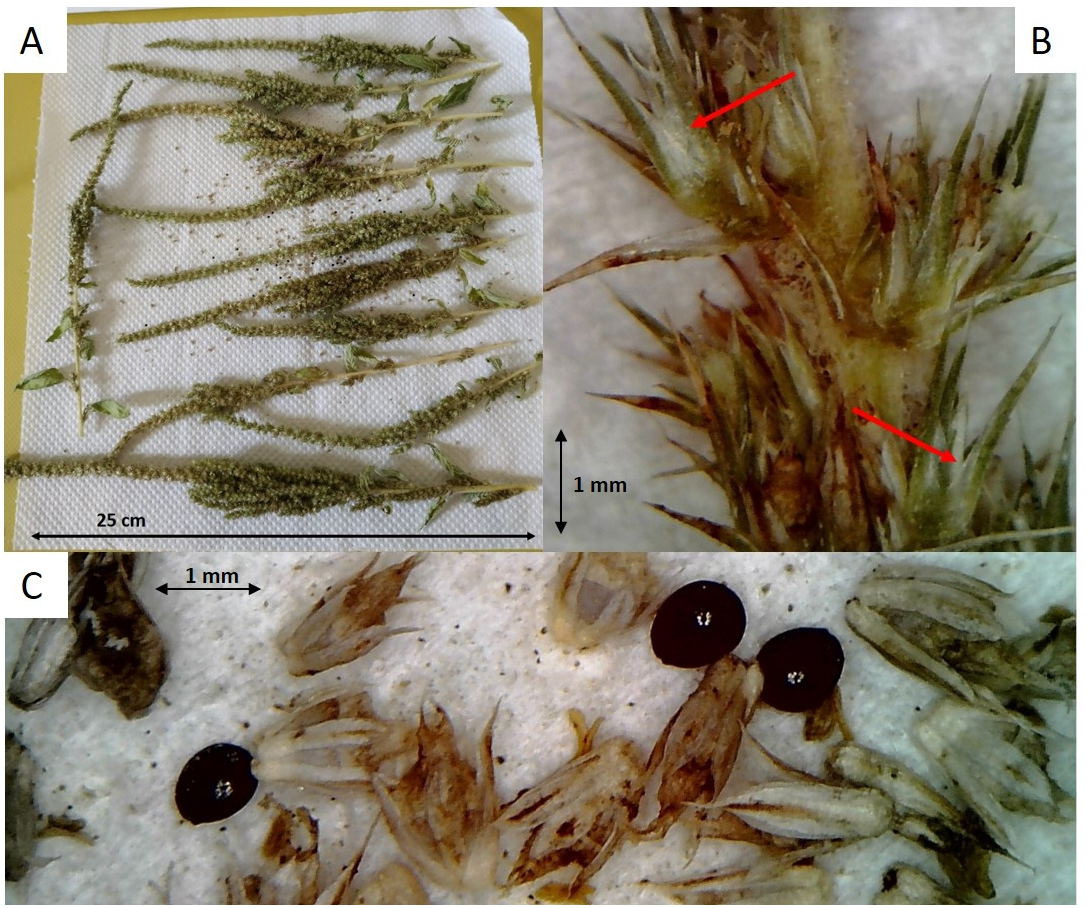
Figure 1. Example of the pictures taken for each of the 51 selected accessions: ( A ) whole inflorescences, ( B ) single inflorescences and ( C ) flowers and seeds. Red arrows indicate a membranous border that, in A. hybridus, stops approximately at half of the bract [8,15].